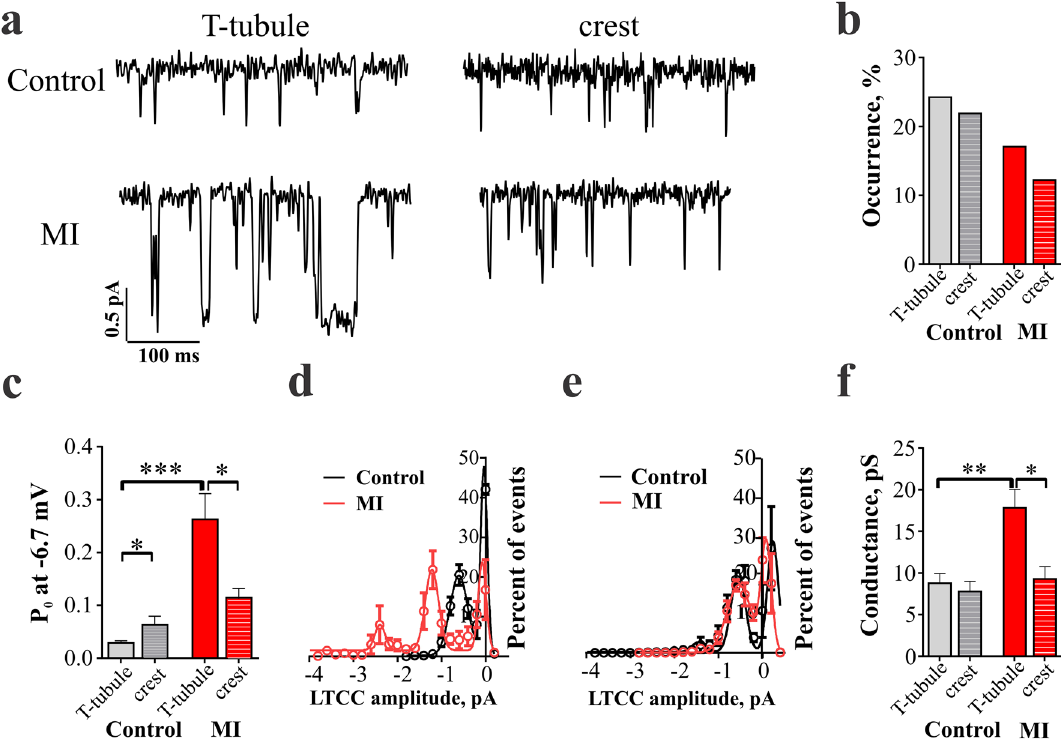
Figure 4. L-type Ca 2+ channel properties in MI RVMs. (a) Representative traces of LTCCs recorded from a holding potential of -96.7 to a depolarizing step of -6.7 mV in T-tubule or crest from control and MI RVMs. (b) LTCC percentage of occurrence at T-tubule and crest regions from control and MI RVMs. Control T-tubule n = 66 cells, crest n = 64 cells; MI T-tubule n = 41 cells, crest n = 41 cells. (c) Open probability (Po) of LTCC at a voltage step of -6.7 mV from control and MI RVMs. Control T-tubule n = 7 cells, crest n = 8 cells; MI T-tubule n = 7 cells, crest n = 5 cells. *P < 0.05, ***P < 0.001, by Kruskal–Wallis test. (d) Amplitude histograms of LTCC (dots) recorded at depolarizing step of -6.7 mV and fit with multicomponent Gaussian functions (connecting curves). Histograms were constructed from n = 6–10 channel activity. LTCC activity was analysed separately for T-tubule and (e) crest channels. (f) Conductance of LTCC located in T-tubule or crest regions of RVMs. Control T-tubule n = 7, crest n = 10; MI T-tubule n = 10, crest n = 12. *P < 0.05, **P < 0.01, by Kruskal–Wallis compared to both the control T-tubule (p < 0.001 vs. control) and the MI crest channels (p < 0.05 vs. MI T-tubule). All-points histograms revealed that single channel amplitude was elevated in T-tubule from 0.59 ± 0.17pA in control to 1.22 ± 0.17pA in MI RVMs and multi-channel openings occurred more likely in T-tubule of MI than control myocytes (Fig. 4d) suggesting an increase in the channel interactions in this microdomain on MI cells. Representative traces and current–voltage relationships for the LTCC located in T-tubule and crest of RVMs are presented in (Supplementary Figs. S4 and S5). From these plots, the average single-channel conductance was calculated, showing that it was also significantly elevated in MI T-tubule LTCC as compared to control T-tubule LTCC (p < 0.01, Fig. 4f). In contrast, no changes in single channel Po or amplitude were found for crest LTCCs (Fig. 4e,f) highlighting the T-tubule localized remodelling of Ca 2+ signalling. Protein kinase A‑dependent phosphorylation of LTCC increases activity of T‑tubule channels in MI RVM. Increase in LTCC Po has been linked to channel phosphorylation, and PKA was shown to be one of the main phosphorylation agents of Ca 2+ handling proteins, including LTCC 21,22 . A recent study of human LVMs from ischemic cardiomyopathy hearts showed that the hyperactive T-tubule anchored LTCCs can be phosphorylated by PKA 23 . To assess if PKA is involved in the elevated Po observed in T-tubule LTCC in MI RVM, we used H89 as a PKA blocker. Traces of LTCC activity recorded at − 6.7 mV in control, untreated MI, and H89-treated MI RVMs are presented in Fig. 5a. Incubation of MI RVMs with 10 µM H89 significantly reduced the Po of LTCC located at T-tubules (p < 0.001 vs MI T-tubule LTCCs) and restored the control values (Fig. 5b). The average conductance of LTCC located in T-tubules of MI RVMs treated with H89 was also significantly decreased to conductance values similar to those of LTCC in control T-tubule (p < 0.05 vs MI T-tubule, Fig. 5c). The cooperative LTCC activation observed in MI TT LTCCs was also reduced to control values after the PKA blockage (Supplementary Fig. S6). To elucidate the impact of PKA phosphorylation on spontaneous Ca 2+ spark and Ca 2+ wave activities we measured them in the presence of H89. Application of H89 returned the frequency of Ca 2+ sparks recorded in line-scan to control levels (Fig. 5d) and reduced Ca 2+ spark mass (Fig. 5e). The enhancement of local Ca 2+ waves